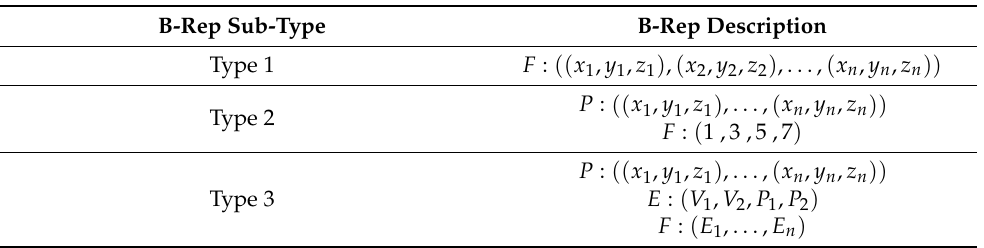
Table 3. Sub-types of B-Rep, including explicit polygons (Type 1), polygons defined by pointers into a point list (Type 2), and explicit edges (Type 3).